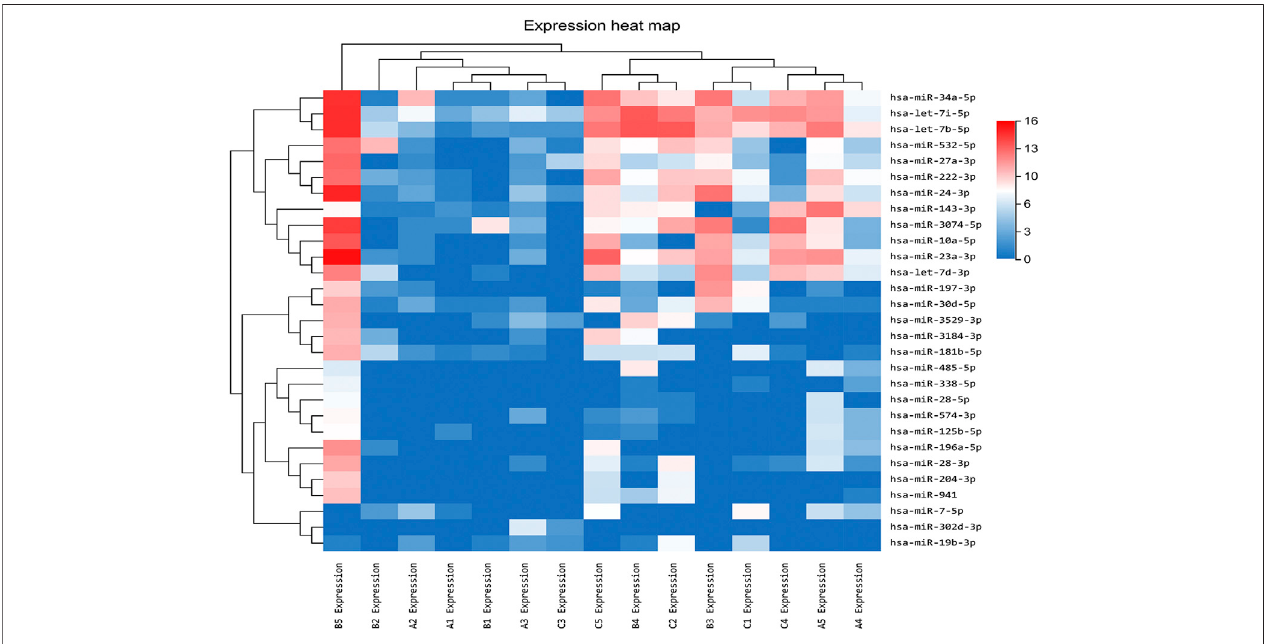
FIGURE 2 | A fl ibercept-induced miRNA pro fi le visualized by hierarchical clustering. Red and blue respectively represent highly expressed and lowly expressed miRNAs. Sample A 1 – 5, B 1 – 5 , and C 1 – 5 respectively represented fi ve samples in control, no-treatment, and treatment